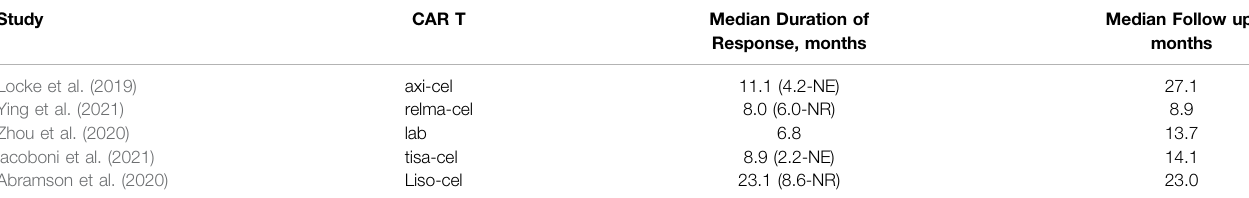
TABLE 4 | Clinical outcome of the duration of response